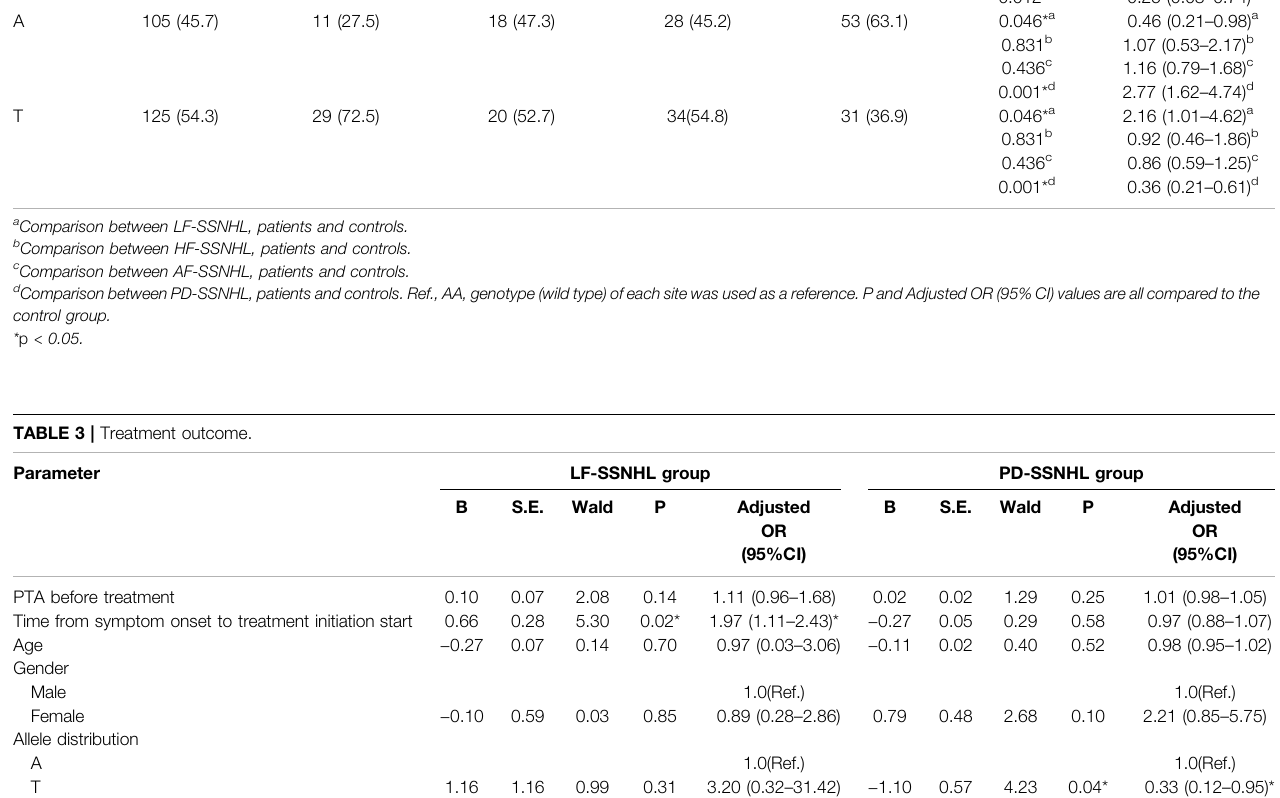
TABLE 2 | Frequencies of alleles and genotypes of p.Ala663Thr polymorphisms in SSNHL patients and controls. The age and sex factors were adjusted in the multivariate logistic regression model. Gene Control type group (%)